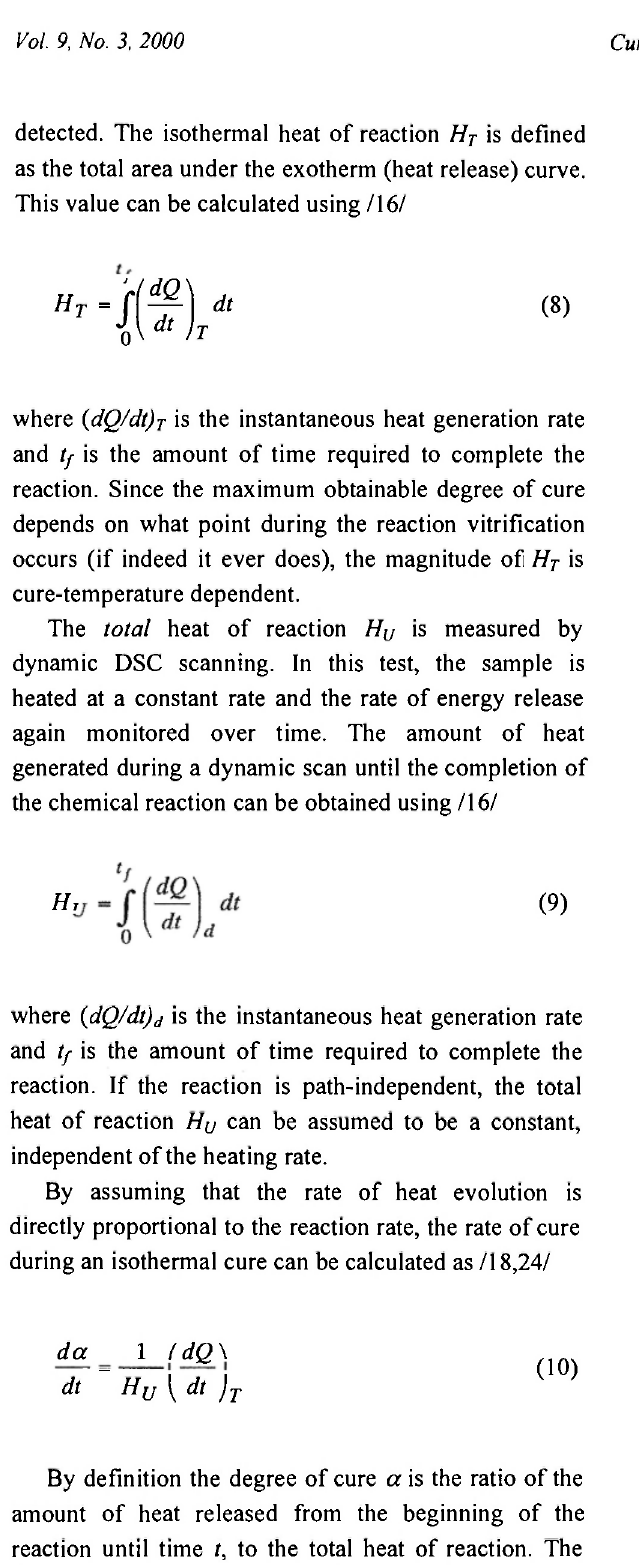
versus inverse of temperature 1/T is shown in Figure